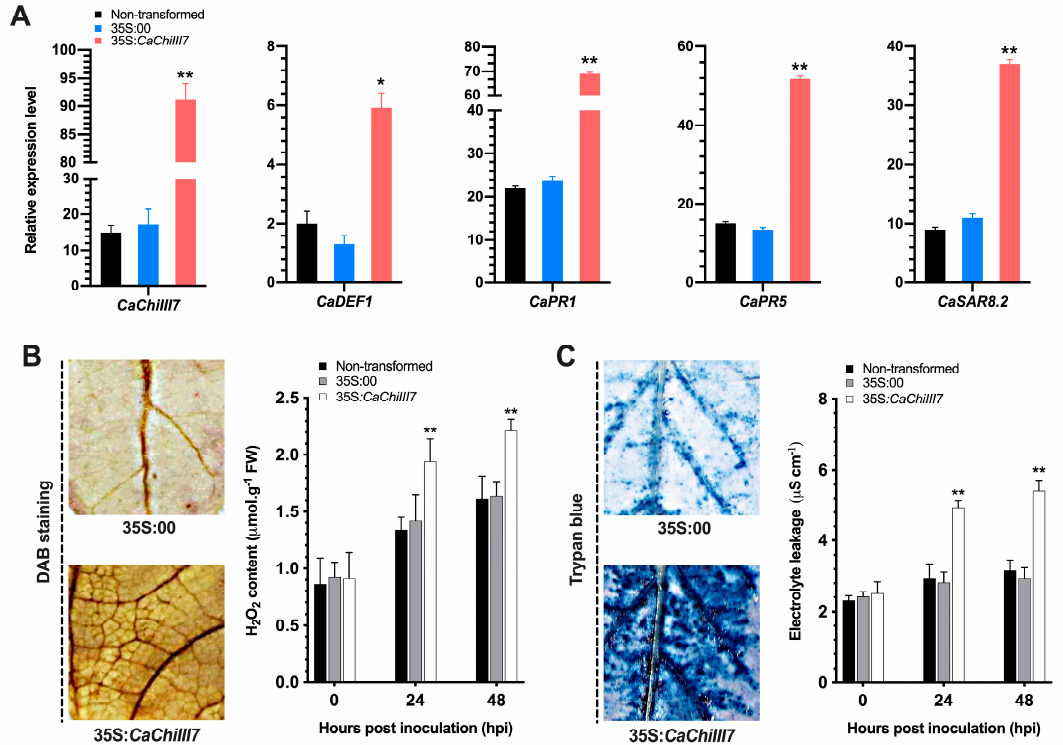
Figure 8. Agrobacterium -mediated chitinase gene CaChiIII7 transient overexpression triggers cell death response and the activation of defense genes in pepper leaves. ( A ) The level of expression of CaChiIII7 and other defense-related genes ( CaDEF1 , CaPR1 , CaPR5 , and CaSAR8.2 ) in CaChiIII7 transiently overexpressed and control pepper plant leaves after 24 h of agroinfiltration. (Note: defense genes were selected based on protein-protein interactions, Figure 2B); ( B ) 3,3-Diaminobenzidine (DAB) staining and quantification of the accumulation of H 2 O 2 in pepper leaves after agroinfiltration. ( C ) Trypan blue staining and the measurement of cell death in agroinfiltrated pepper leaves (0.5 cm diameter leaf discs). The electrolyte leakage caused by the cell death was examined using quantifying ion conductivity at indicated periods after agroinfiltration at the titer (OD 600 = 1.0). Values are the means ± standard deviations (SD), and asterisk(s) denotes significant and di ff erences as analyzed by a Duncan’s multiple range (DMR) test ( p < 0.05).